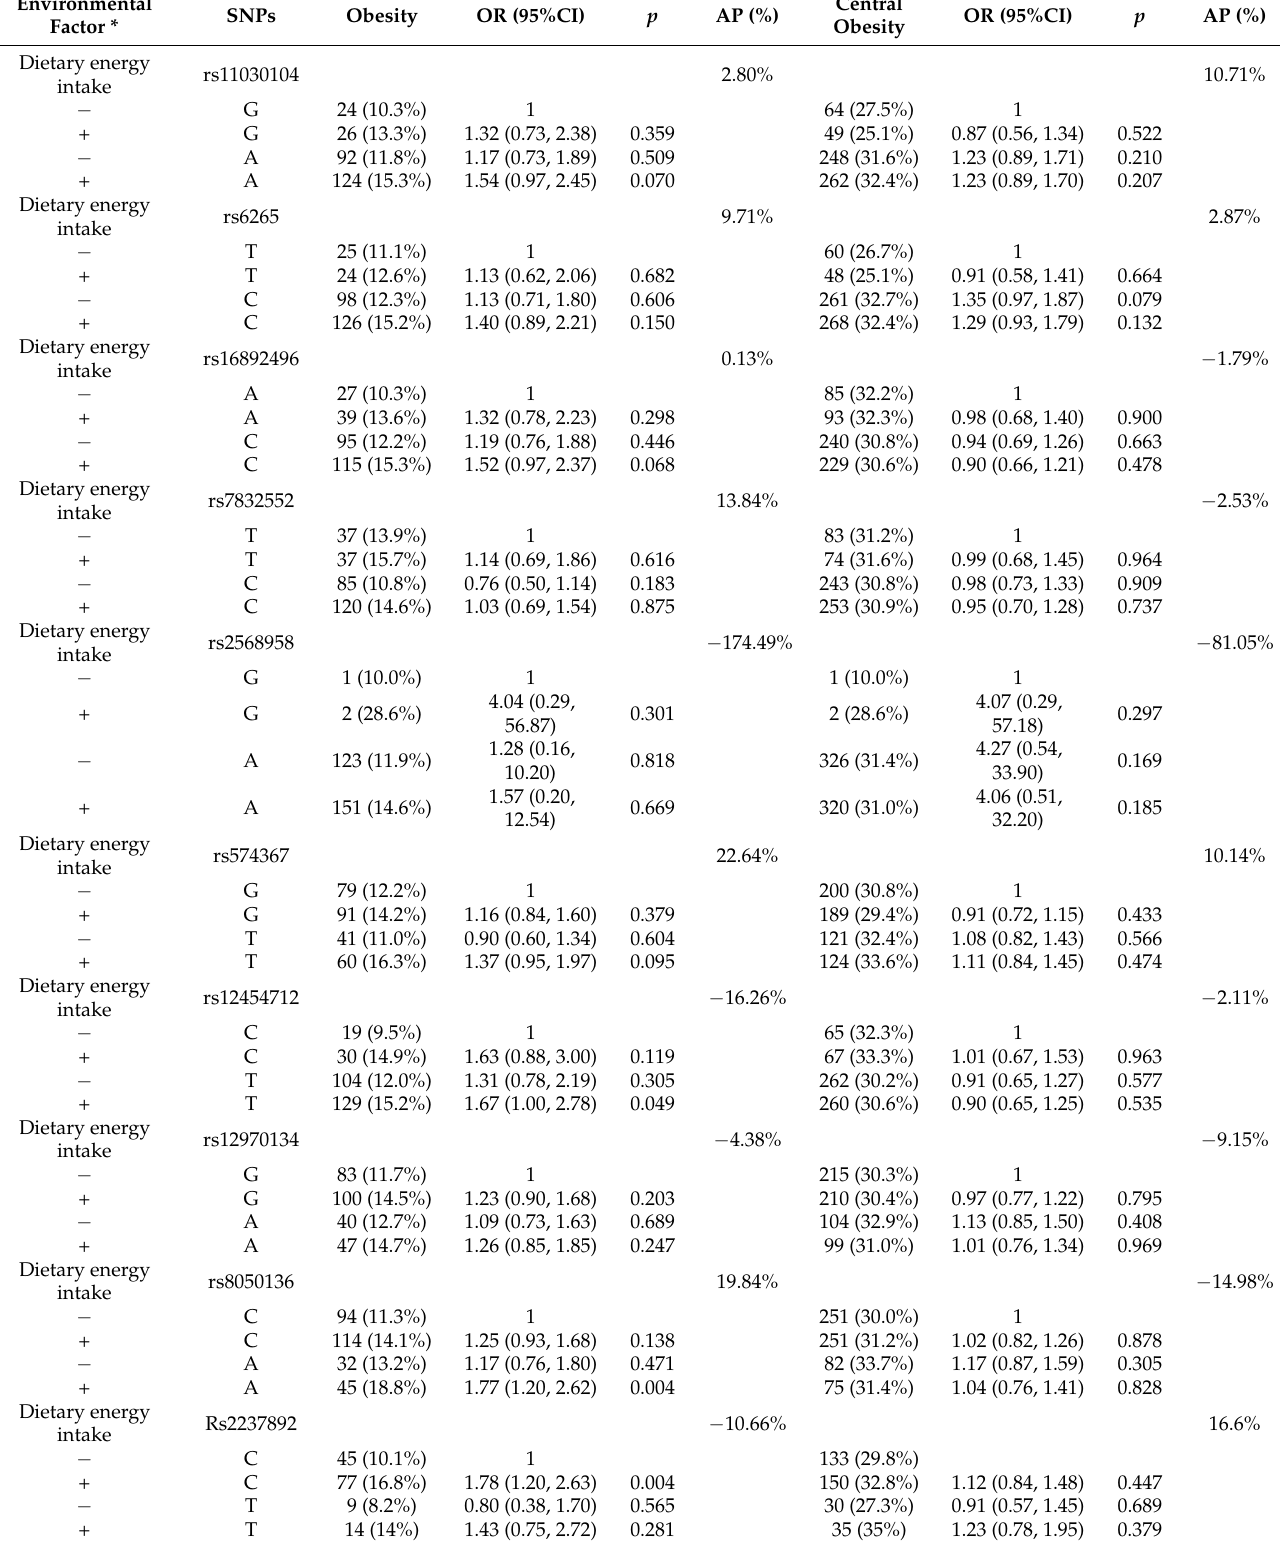
Table 6. The interaction between dietary energy intake and SNPs in obesity and central